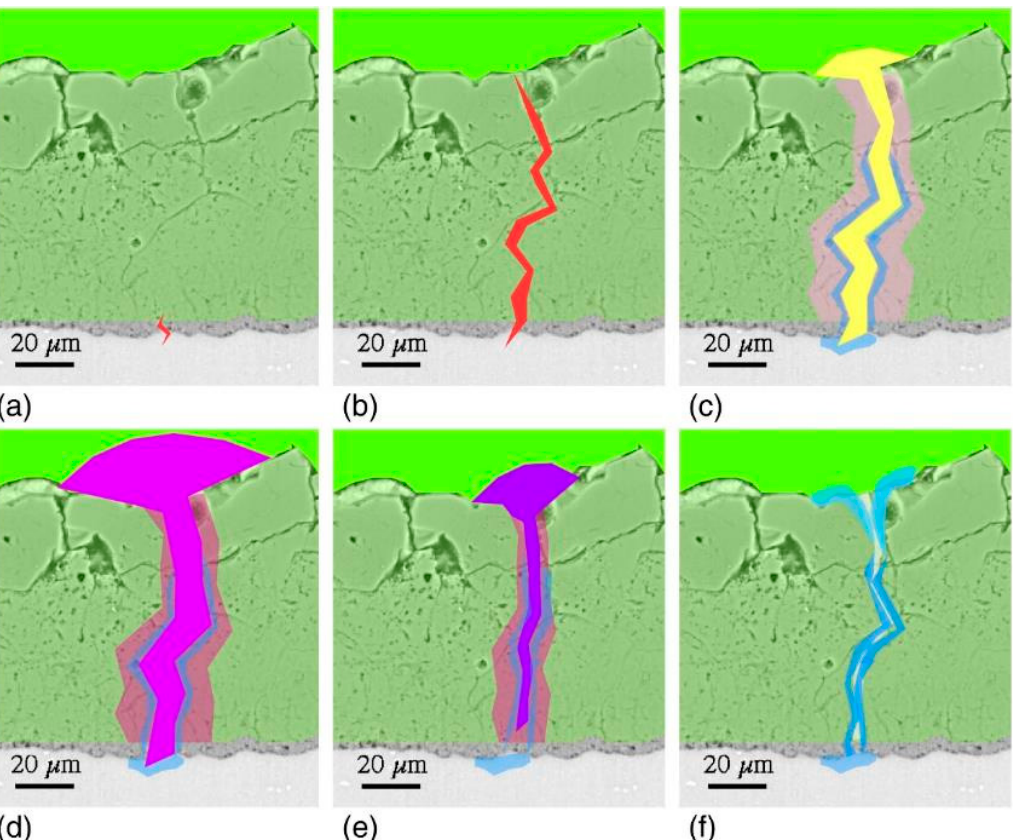
Figure 4. Schematic depiction of the sequence of events during a single discharge, showing: ( a ) initial electrical breakdown, ( b ) the development of the plasma channel through the coating thickness, ( c ) initial bubble growth and formation of oxide in the plasma, ( d ) bubble expansion and heating of the region around the discharge, ( e ) shrinkage and cooling as the plasma resistance rises, causing the current to fall, and ( f ) final quenching and the expulsion of some liquefied oxide from the channel [47].